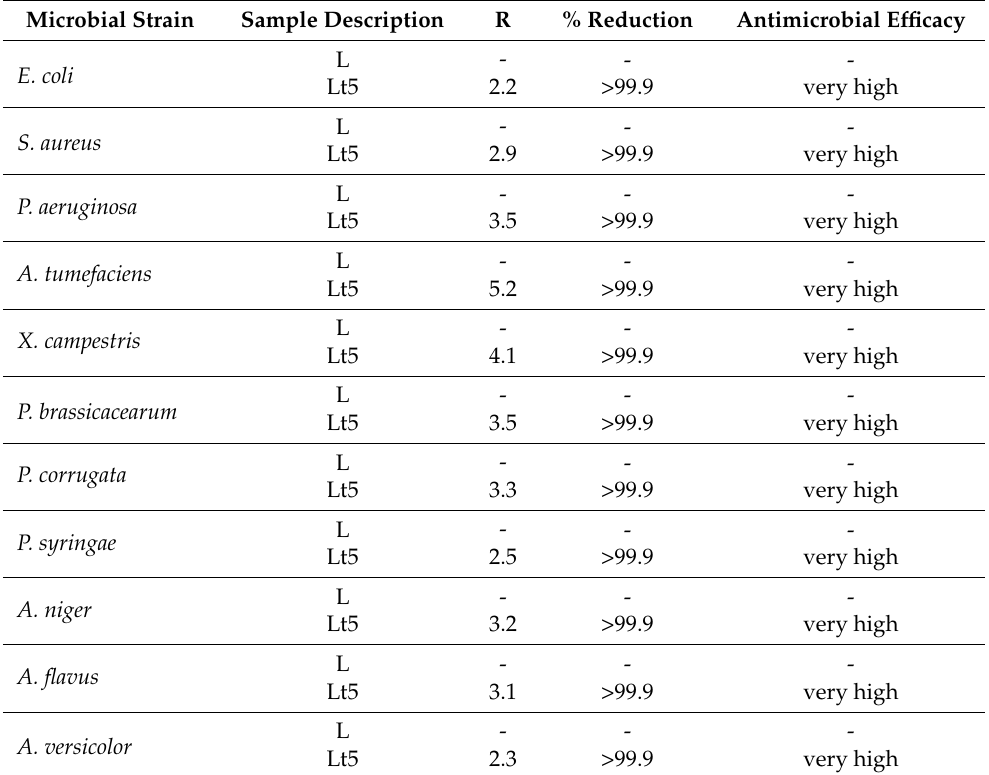
Table 3. Antimicrobial activity of PLA film with birch tar (Lt5) with reference to the control sample —PLA film (L) against pathogen strains.